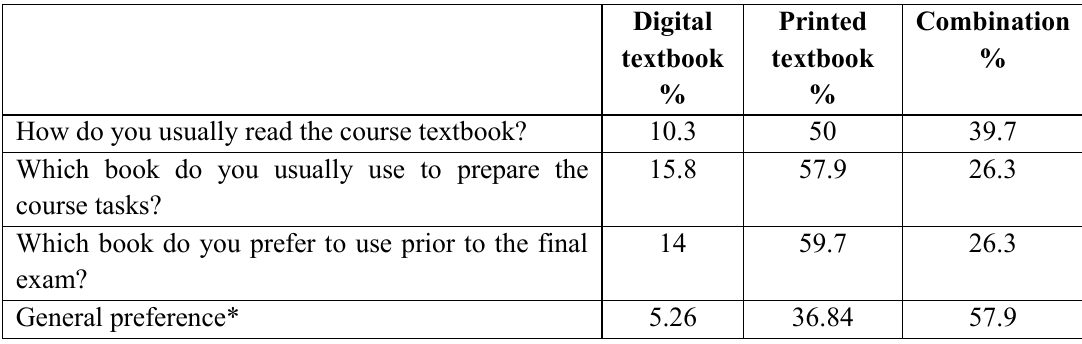
Students’ Preferences Regarding the Textbook Format (printed, digital, or combination) in relation to Various Learning Assignments